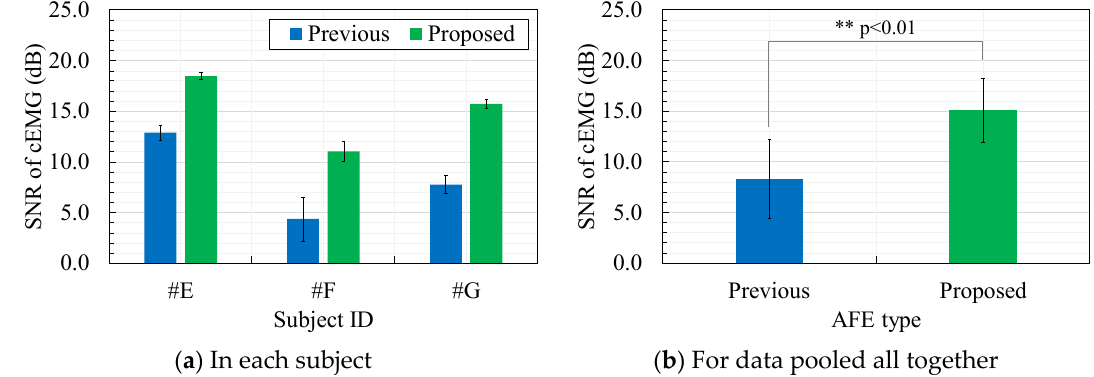
Figure 11. Comparison of the signal-to-noise ratio (SNR) of recorded cEMG between the previous and proposed AFEs: ( a ) Comparison for each subject, ( b ) Comparison for data gathered from all subjects.